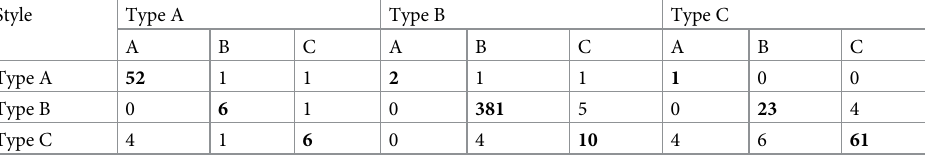
Rows are the Linear Discriminant Analysis assignments and columns are the Random Forest assignments.